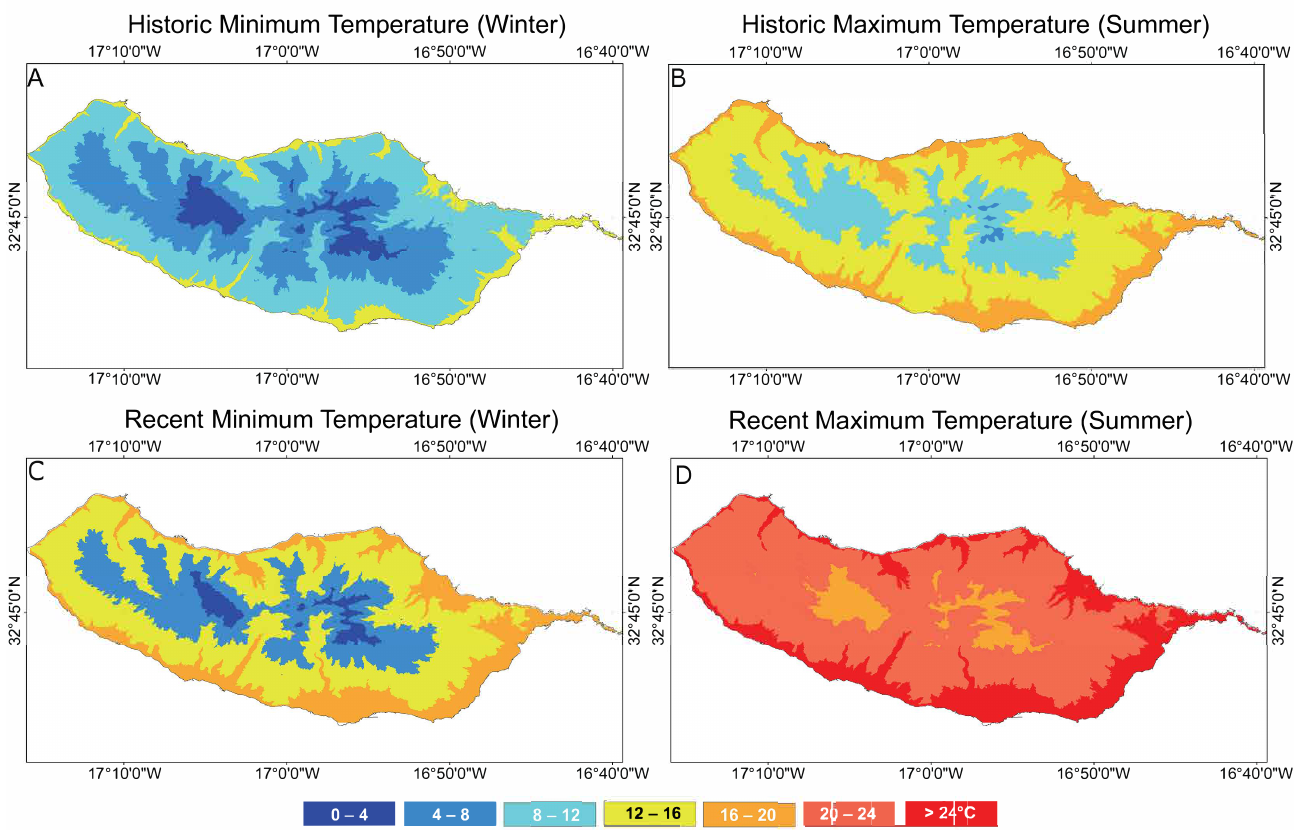
Figure 2. Spatialization of the average temperature of Madeira Island in extreme events of sum- mer and winter, using the historical series (1960–1991), maps ( A , C ), and recent series (2010–2020) maps ( B , D